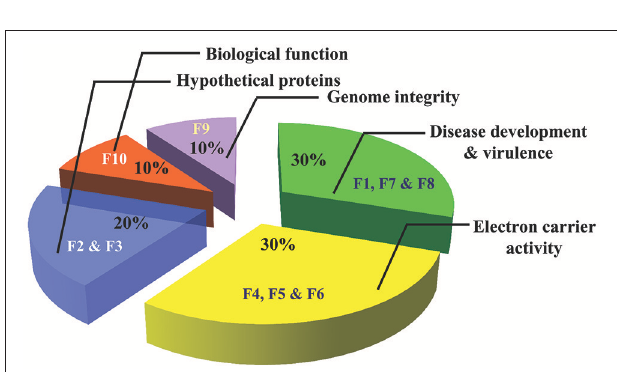
FIGURE 6 | Pie charts of proteins identified from virulent and less virulent isolates and its functions (F1–F10 proteins spot codes).